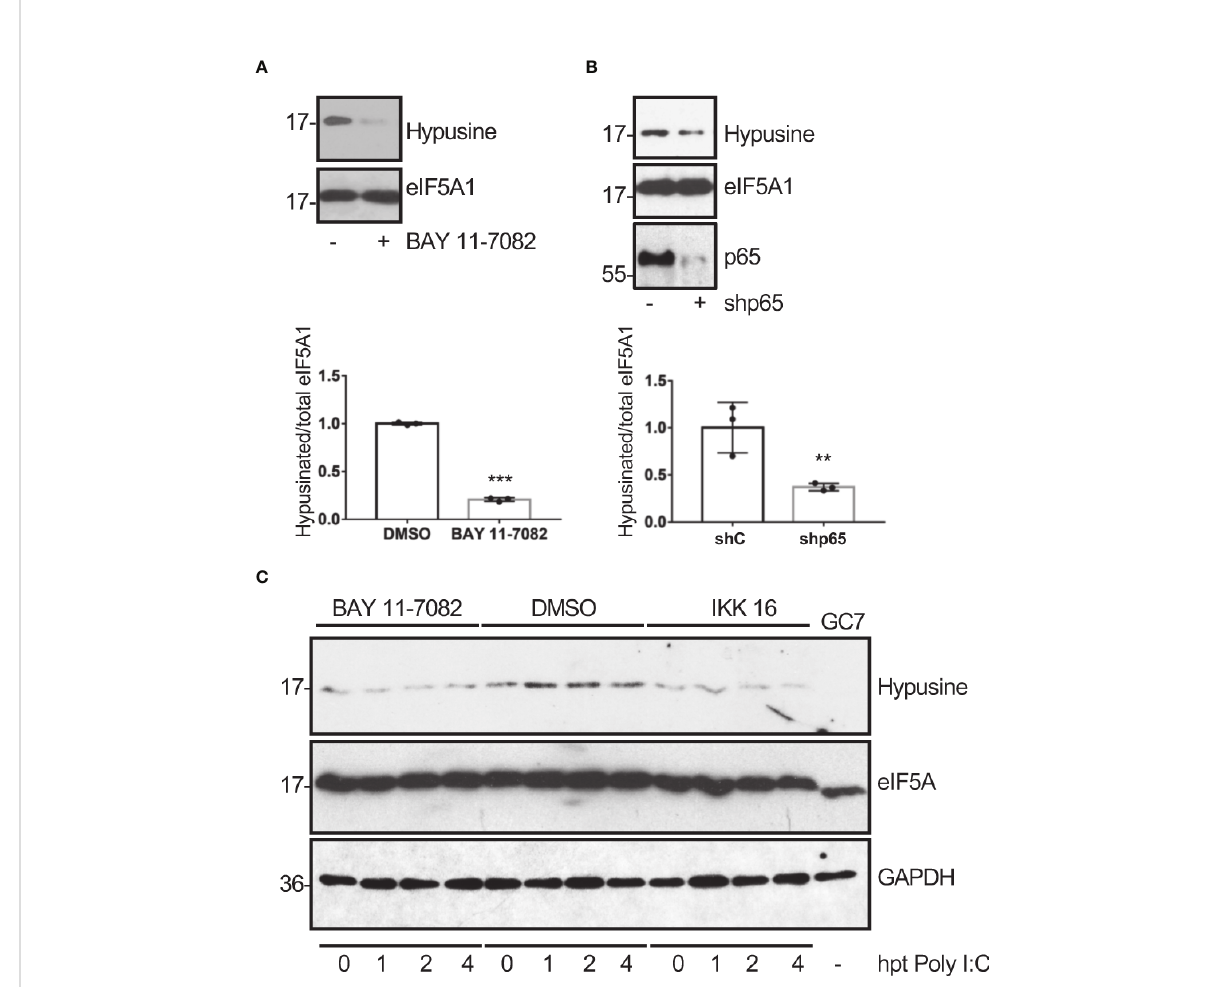
FIGURE 3 Modulation of eIF5A activation by NF- k B. Hypusine levels in A549 cells treated with BAY 11-7082 (1 m M) or DMSO for 1 h (A) or transduced with a retrovirus vector expressing short hairpin RNA (shRNA) targeting p65 subunit of NF- k B (shp65) (B) . Hypusinated eIF5A and protein intensity bands from three biological replicates were quanti fi ed using Image J software. Hypusinated/total eIF5A ratio from each respective time were plotted. Data represent the mean and error bars of three biological replicates (lower panels). Statistical analysis was assessed by a Student ’ s t-test. **, P< 0.005; ***, P< 0.0005. (C) , Activation of eIF5A in response to poly I:C transfection in A549 cells treated with BAY 11-7082 (1 m M), IKK 16 (100 nM) or DMSO, as